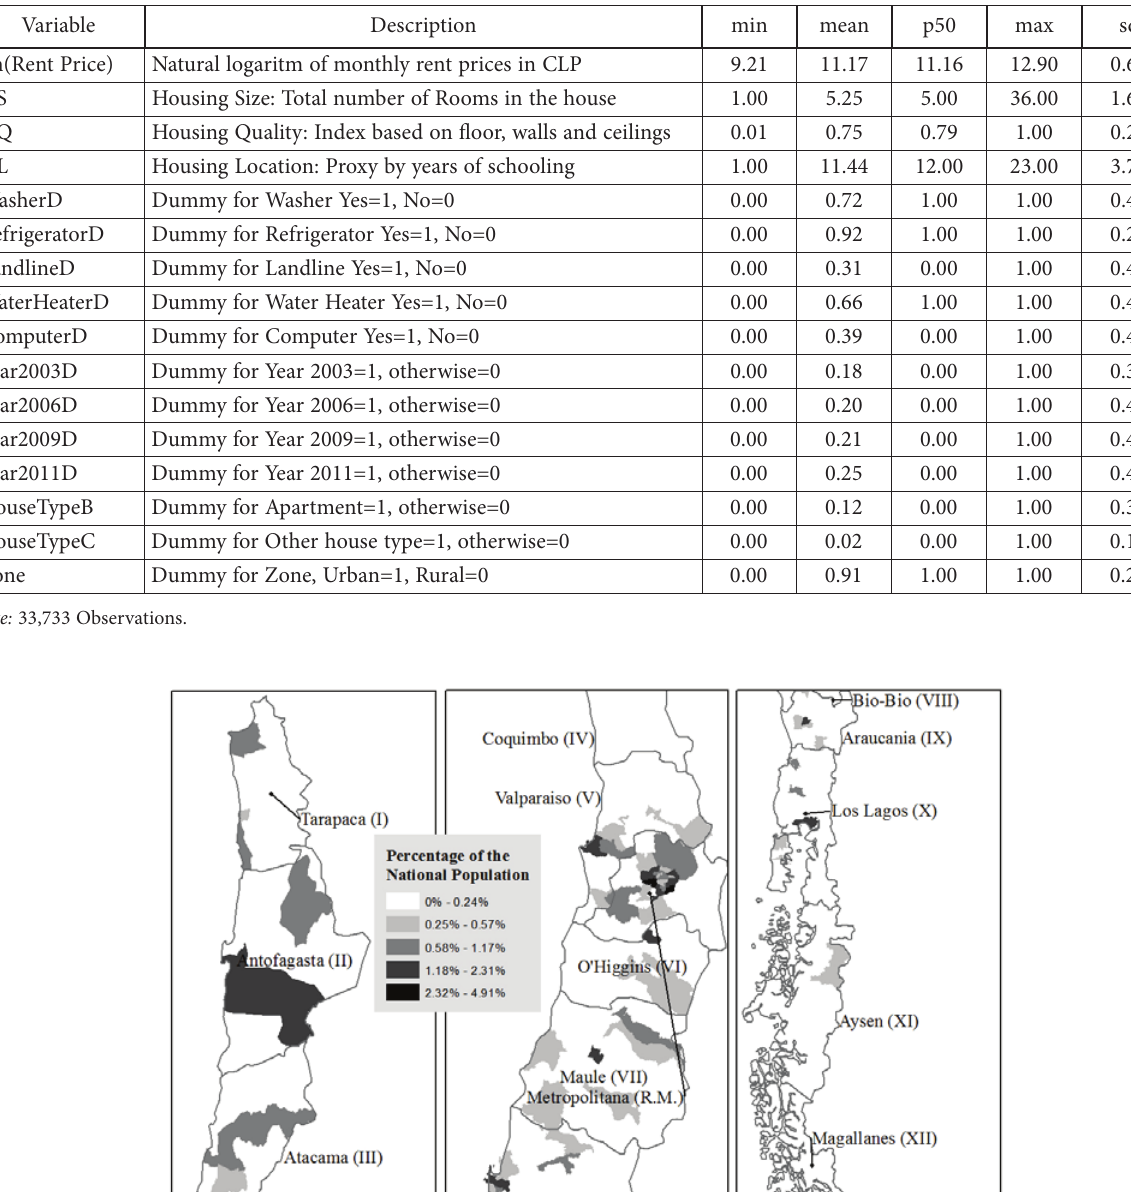
Table 1. Descriptive analysis for hedonic regression